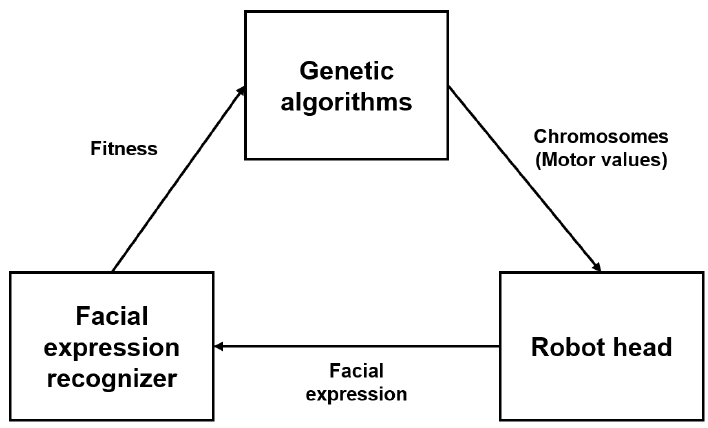
Figure 8. Facial expression generation system based on